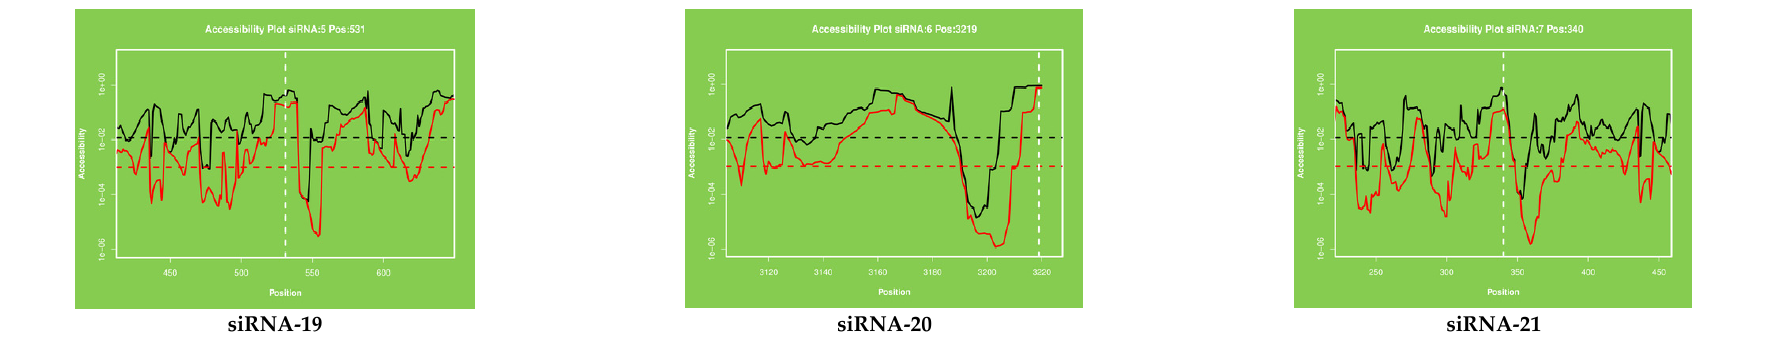
Figure 4. The accessibility to the target site for each nucleotide in the sequence. The proposed target accessibility plot of different siRNAs (siRNAs 1–21) was determined by RNAxs online software. Each full-length sequence target was submitted to the RNAxs online server. The target accessibility probability profile for each site targeted by the siRNA is displayed. Accessibility and targeted binding position of each siRNA have been shown as a dotted line. Each siRNA has different binding positions in the viral genome. X axis represents the efficiency and Y axis represents the binding position of siRNAs in the viral genome.